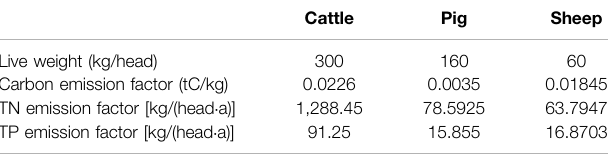
TABLE 2 | Carbon and nutrient emission factors of livestock in the CBYN. Cattle Pig